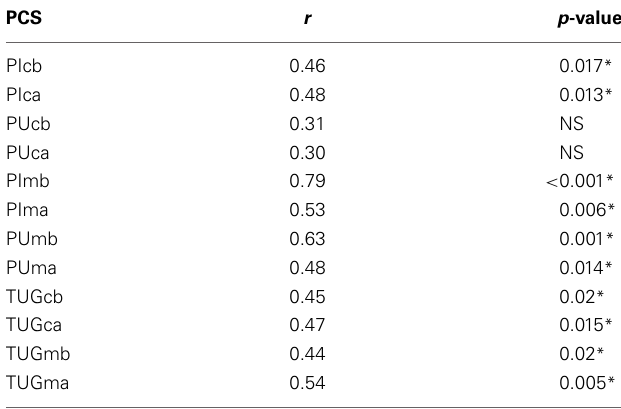
Table 3 | Correlations with Pain Catastrophizing